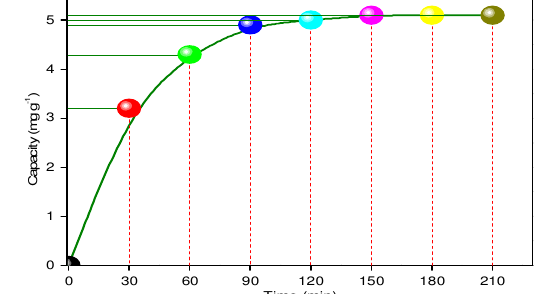
Fig. 12: Adsorption Kinetics of As(III) (Adsorbent Dose 0.5 g Per 50 ml, pH 6, Range of Reaction Time 0-210 Min, Temp: 25 ± 2 o C, As (III) Concentration 70 mg L -1 )